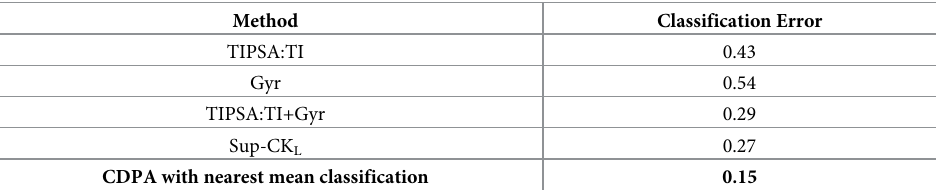
Table 3. Results for nearest mean classification for the Kahraman